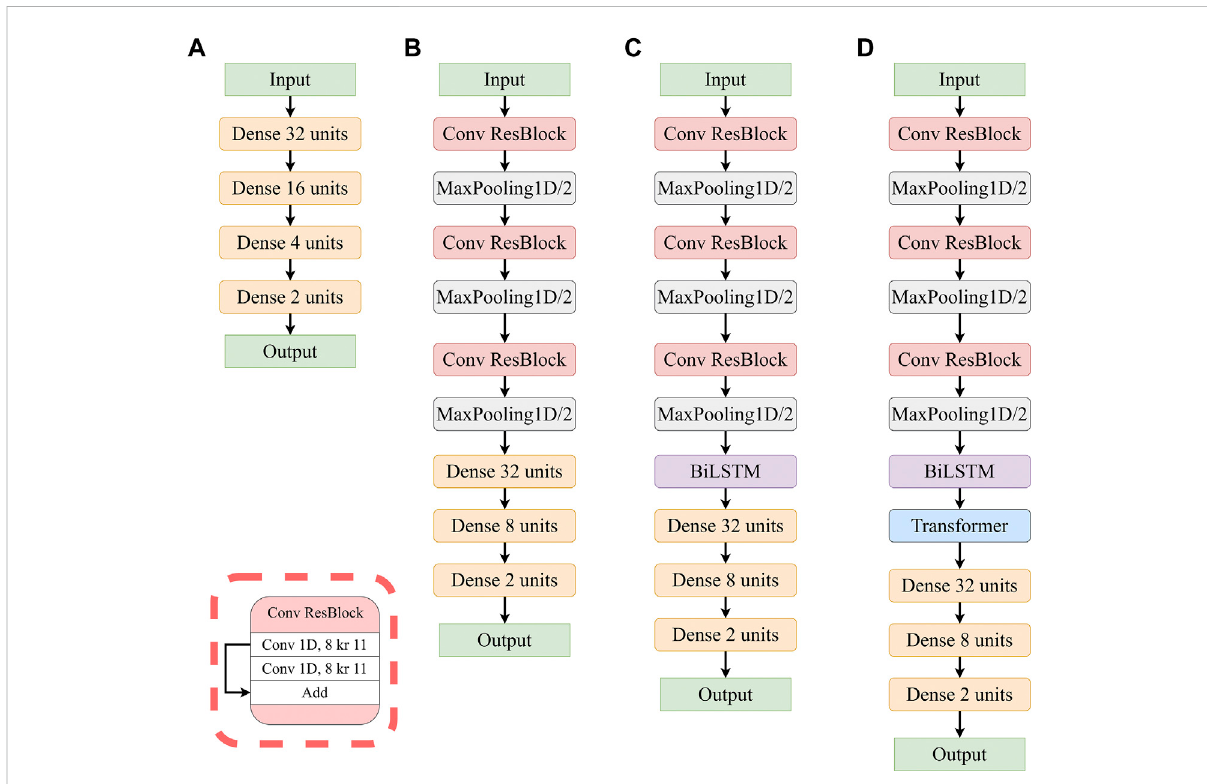
FIGURE 1 Diagrams of the four deep learning models. (A) FC model. (B) CNN model. (C) CNN-BiLSTM model. (D) CNN-BiLSTM-Trans model.